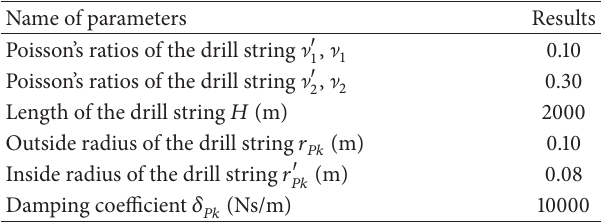
Table 5: Calculated parameters of Poisson’s ratio